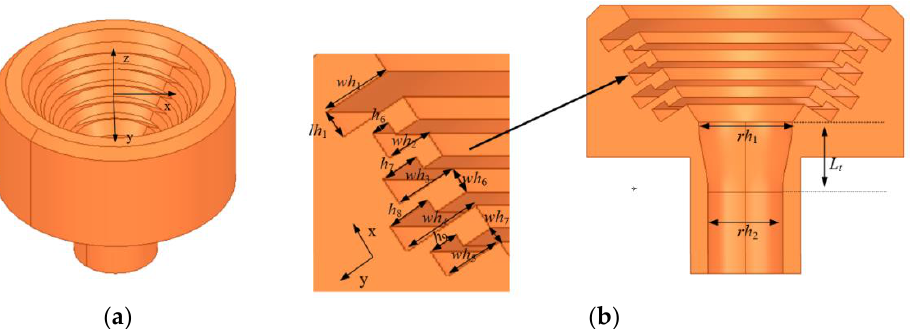
Figure 12. Simulated model diagram of the conical corrugated horn: ( a ) 3D view. ( b ) Cross-sectional view.